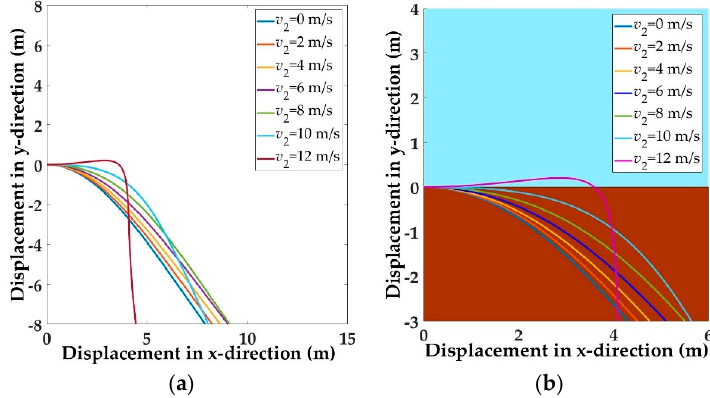
Figure 5. Trajectories of Anchiornis running at a speed of 5 m/s and 𝜽 = 0 ° : ( a ) 𝒗 𝟐 changes from 0 to 12 m/s; ( b ) 𝒗 𝟐 changes from 0 to 12 m/s.